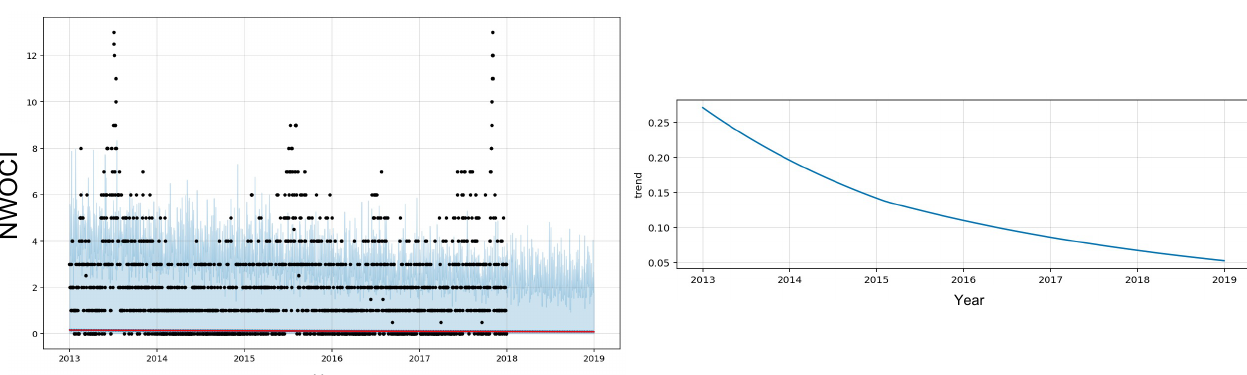
Figure A11. Left : One year forecast (2018 test data) from Prophet-BU Model for Franklin county in MA. N.B: The solid blue line shows the average forecast while the solid red line shows the observed trend of NWOCI and the light blue represents region represents the 80% confidence interval for the forecast uncertainty. Also, the scatter points represent the historical values in the training data (2013–2017). Right : Corresponding trend decomposition from Prophet-BU